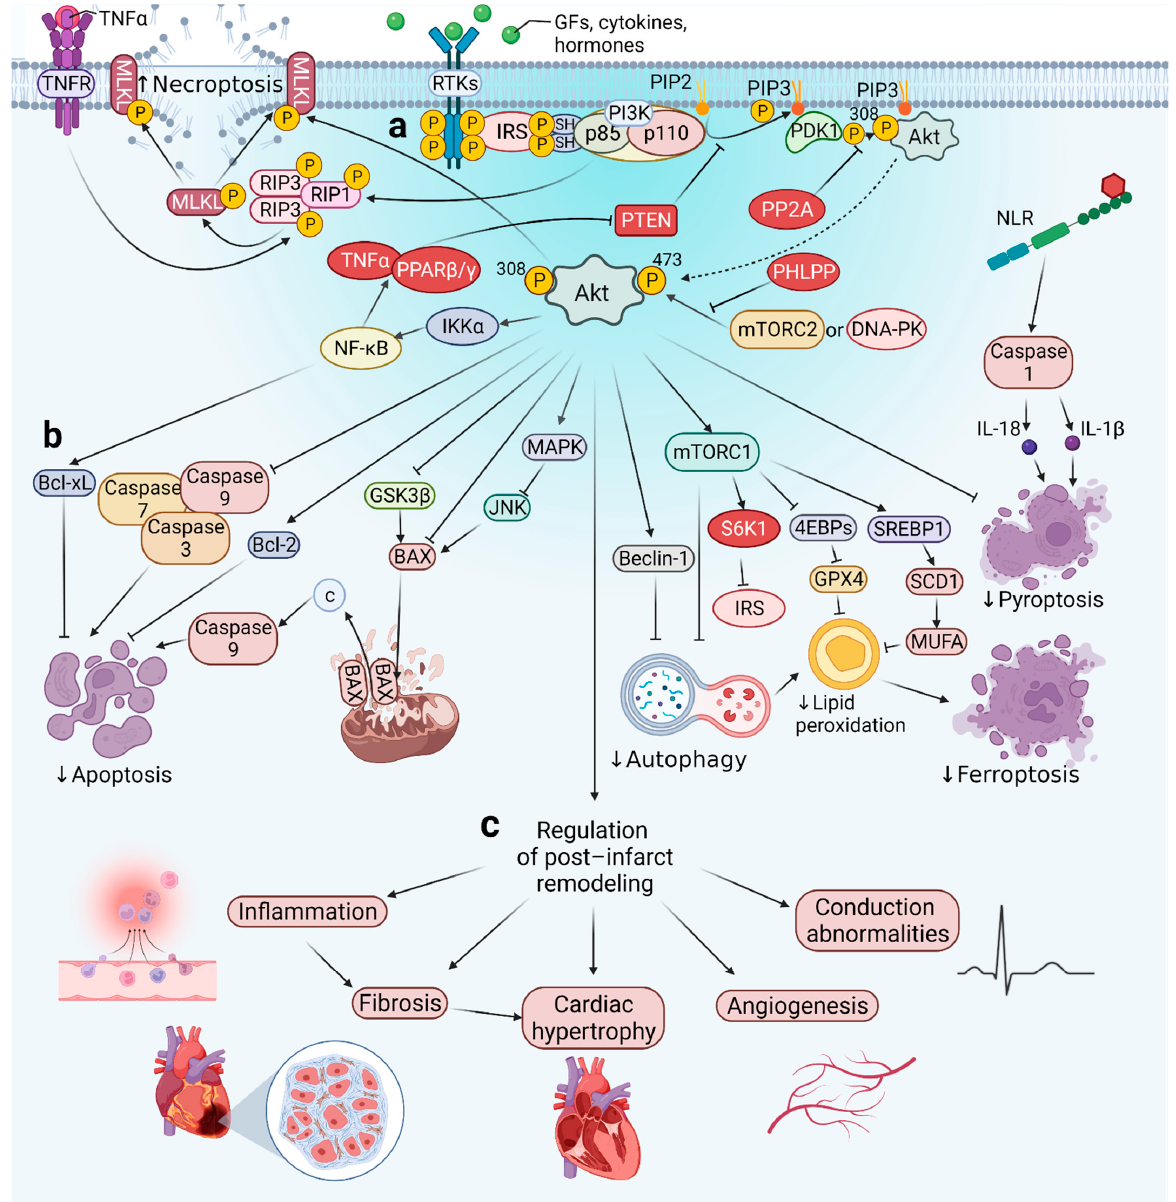
Figure 1. Schematic of components and mechanisms of PI3K/Akt activation and regulation ( a ). PI3K/Akt pathway regulates cell death during MI ( b ). PI3K/Akt signaling is a key component in the regulation of numerous processes in the peri-infarct period and post-infarction remodeling of the left ventricle ( c ). Akt—protein kinase B, Bax—Bcl-2-associated X protein, Bcl-xL—B-cell lymphoma- extra large, Bcl-2—B-cell lymphoma 2, c—cytochrome c, DNA-PK—DNA-dependent protein ki- nase, GFs—growth factors, GPX4—glutathione peroxidase 4, GSK3 β —glycogen synthase kinase 3 β , IKK α —I κ B kinase α , IL-1 β , IL-18—interleukins 1 β and 18, IRS—insulin receptor substrate, JNK— c-Jun NH 2 -terminal kinase, MAPK—mitogen-activated protein kinase, MUFA—monounsaturated fatty acids, MLKL—mixed lineage kinase domain-like protein, mTORC1, mTORC2—mammalian target of rapamycin complex 1 and 2, NF- κ B—nuclear factor κ -light-chain-enhancer of activated B cells, NLR—NOD-like receptor, P—phosphate, PDK1—phosphoinositide-dependent kinase-1, PHLPP—pleckstrin homology domain leucine-rich repeat protein phosphatase, PIP2—phosphati-